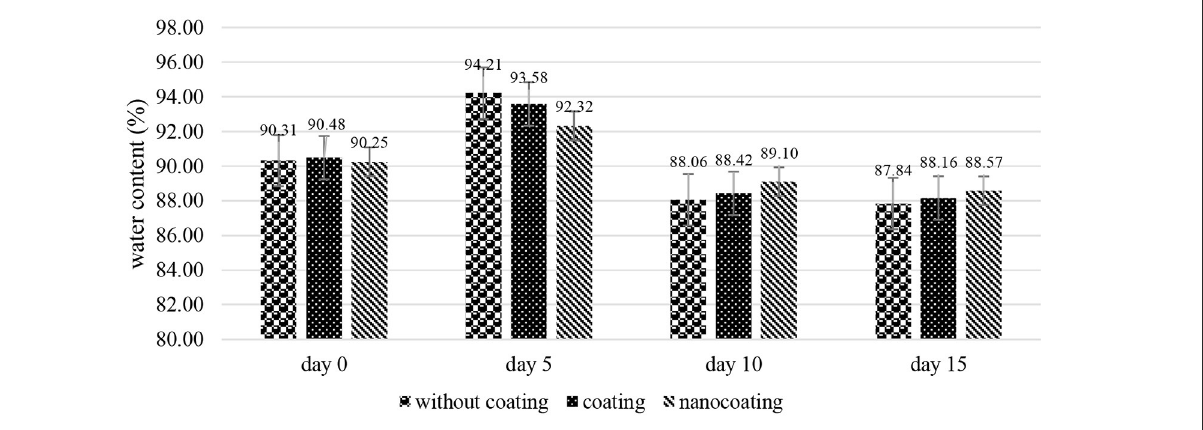
FIGURE6 Water content (%) of Siamese